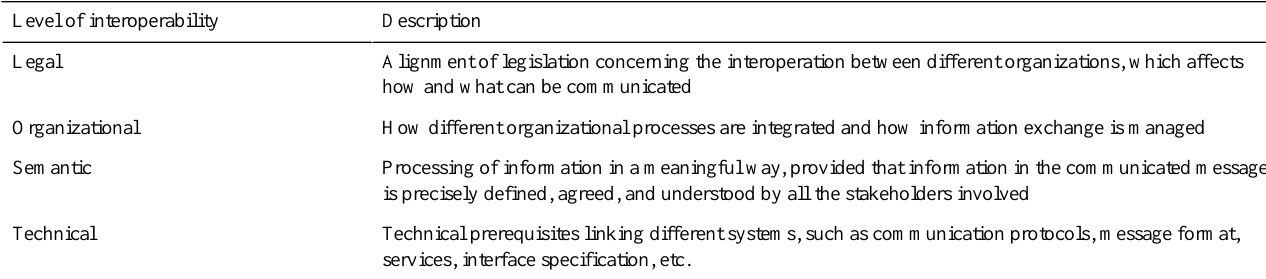
Table 1. Levels of interoperability. DescriptionLevel of